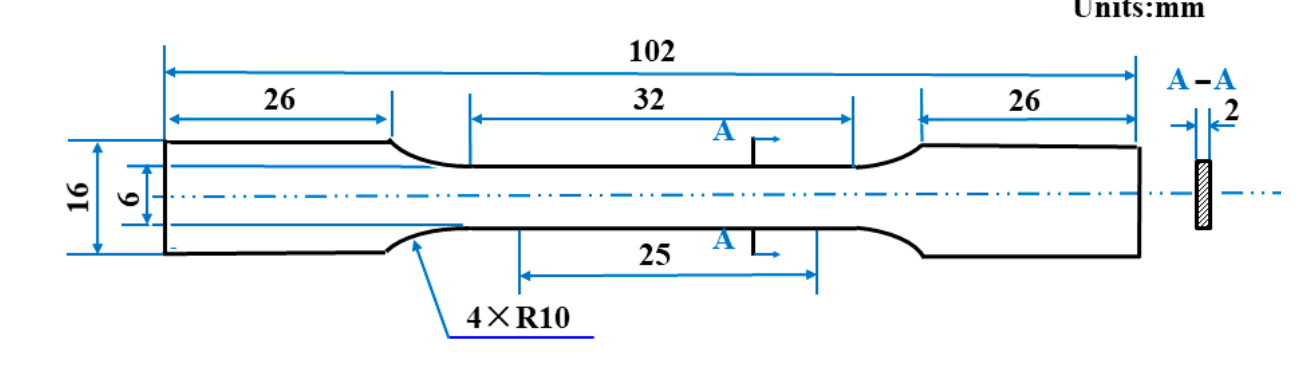
Figure 2. Diagram of tensile sample.